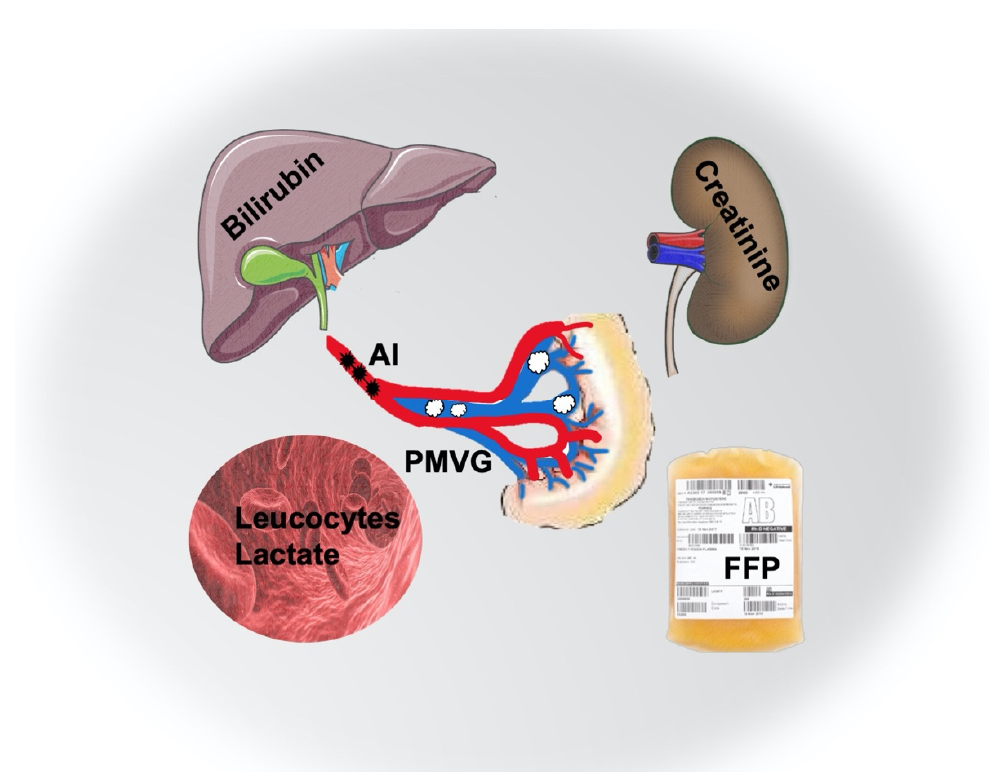
Figure 1. Major risk factors for mortality acute mesenteric ischemia. The graphical synopsis sum- marizes the major risk factors for mortality in acute mesenteric ischemia. Back dots indicate arterial occlusion, while white clouds indicate PMVG. AI, arterial ischemia; FFP, fresh frozen plasma; PMVG, portomesenteric vein gas.